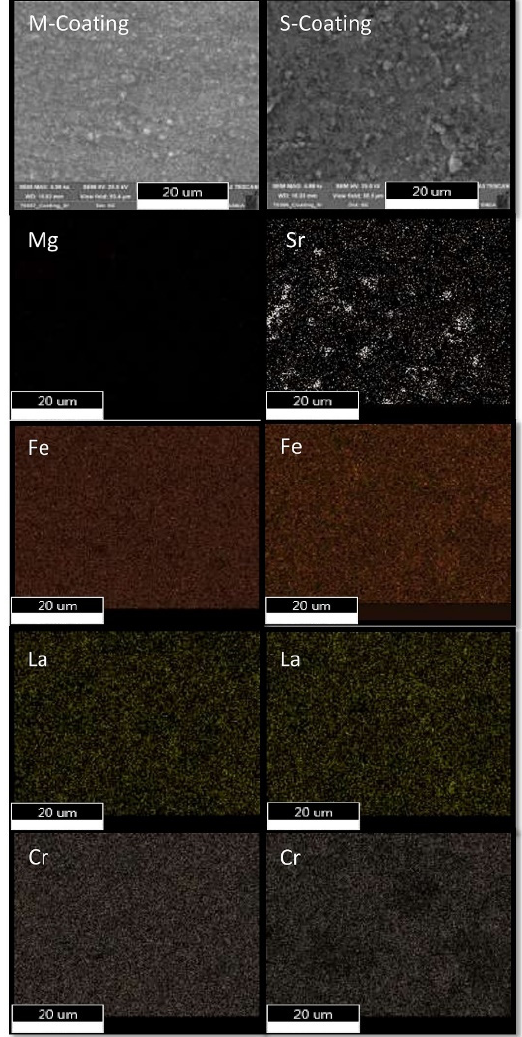
Figure 4. Surface morphology and EDX element distribution mapping for M-coating and S-coating samples.